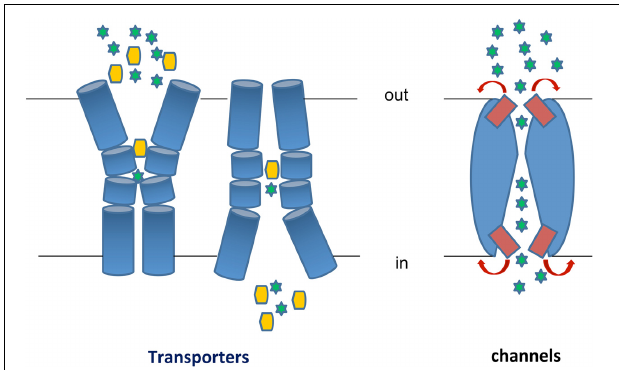
FIGURE 1 | Transporters vs. Channels. Left: A transporter undergoes a major “rocking-switch” conformational alteration from an outward- to an inward-facing topology elicited by the binding of a substrate molecule (shown as a yellow hexagon) to specific residues within a substrate-binding pocket located deep in the transporter body at the plane of the plasma membrane. Substrate molecules can be translocated either uphill or downhill of their concentration gradients, depending on the whether the transporter is a secondary active transporter (symporter or antiporter) or a facilitator. The cartoon depicts a symporter, where substrate binding and/or translocation necessitate cation (H + or Na + , shown as green stars) binding and transport downhill their concentration gradient. In antiporters, substrate uptake is exchanged with export of another metabolite or cations (e.g., K + or Ca 2 + ). During each transport cycle, the bound substrate molecule is never exposed to both sides of the membrane simultaneously. Transporters obey Michaelis-Menten kinetics resembling enzymes, albeit catalyzing a topological rather than a chemical reaction. Most transporters are monomers made of several usually 10–14 transmembrane α -helical, segments (TMS). Right : A channel potentially forms a continuous pore but in most cases this pore is restricted by so called selectivity filters and controlled by gating domains or gates (shown in red). Once activated or open, a channel allows continuous translocation of several substrate molecules (shown as green stars), which are mostly ions or small polar compounds, from both sides of the membrane simultaneously. A channel can only mediate facilitated diffusion of substrate molecules down